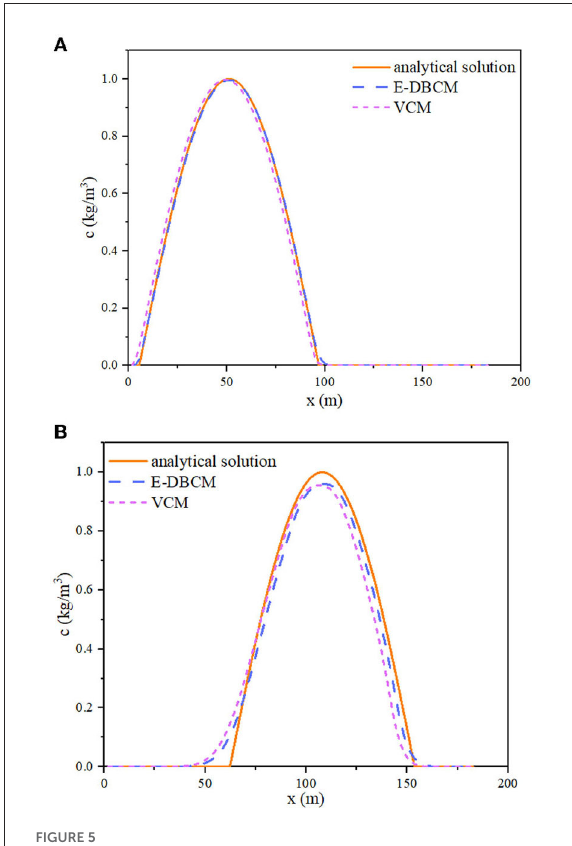
FIGURE5 Pollutant concentrations at different times: (A) t = 500 s ; (B) t = 1,000 s .